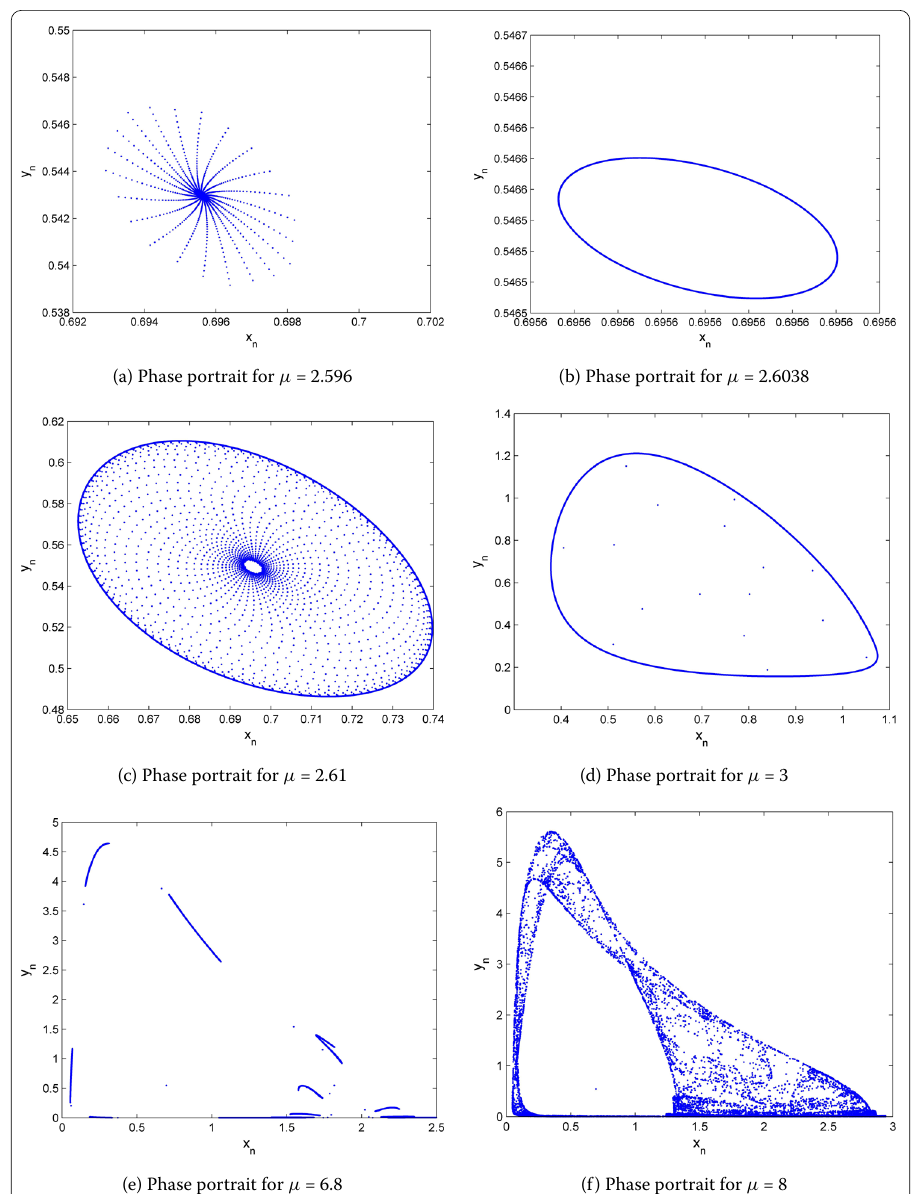
Figure 13 Phase portraits of system (1.5) for ν = 4.1, η = 1.5, x 0 = 0.6956, y 0 = 0.5465 with different values of